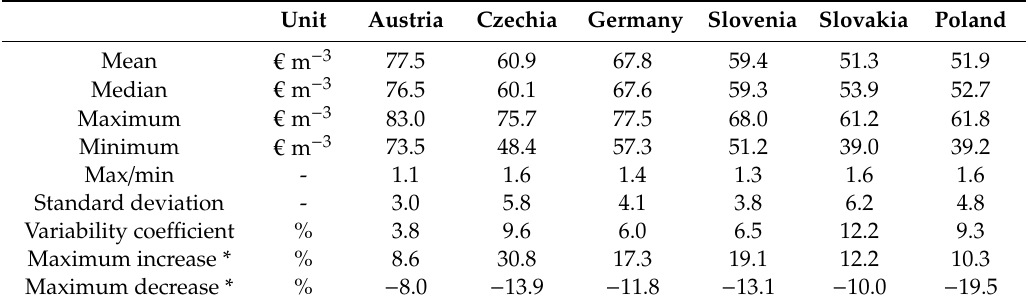
Table 1. Descriptive statistics for quarterly time series of beech roundwood prices in selected European markets.